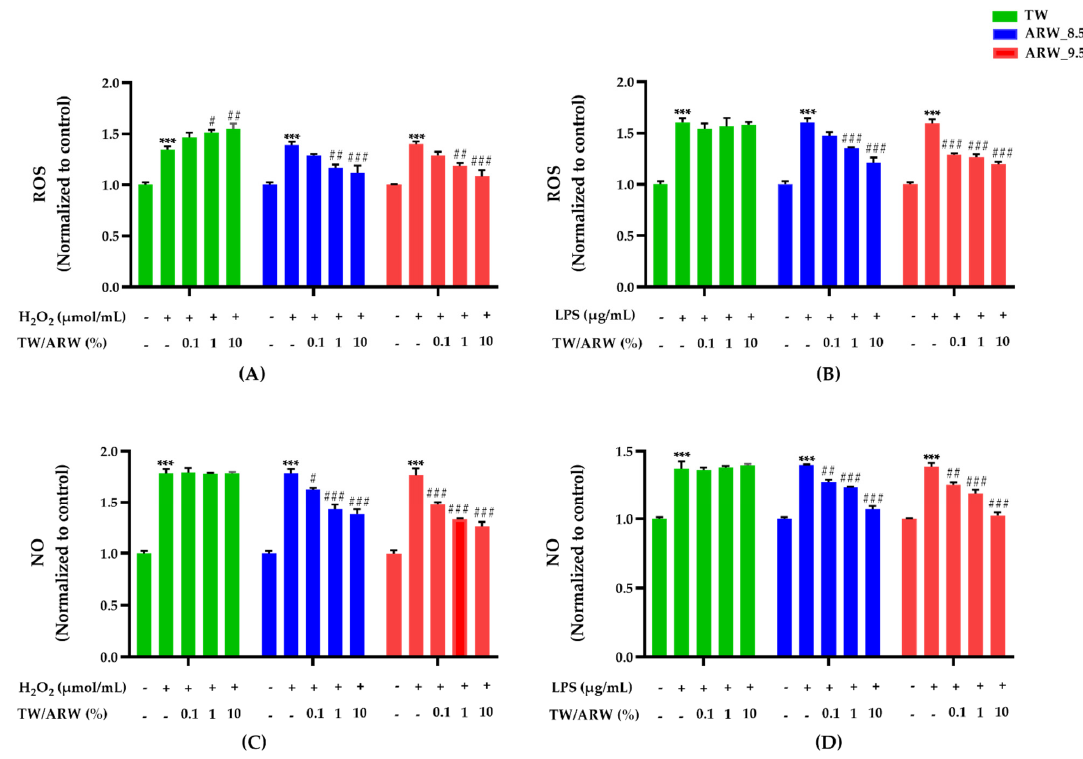
Figure 2. Effect of ARW_8.5 and ARW_9.5 on the level of ROS and NO in H 2 O 2 − and LPS-induced RAW 264.7 murine macrophage cells. The levels of ROS and NO were induced by H 2 O 2 (200 µmol/mL for 2 h) ( A , C ) and LPS (10 µg/mL for 24 h) ( B , D ), and the cells were treated with ARW (pH 8.5 and pH 9.5) at concentrations of 0.1%, 1%, and 10%. Data are expressed as the mean ± standard error of the mean (SEM) of the fold change relative to the control ( n = 3). Statistical significance was analyzed with two-way ANOVA. ( − ): non-treatment, (+): treatment. ***, p < 0.001 vs. normal control. # , p < 0.05; ## , p < 0.01, and ### , p < 0.001 vs. Con/H 2 O 2 or Con/LPS. Abbreviations: ARW, alkaline reduced water; TW, tap water; H 2 O 2 , hydrogen peroxide; LPS, lipopolysaccharide; ROS, reactive oxygen species; NO, nitric oxide; Con, control